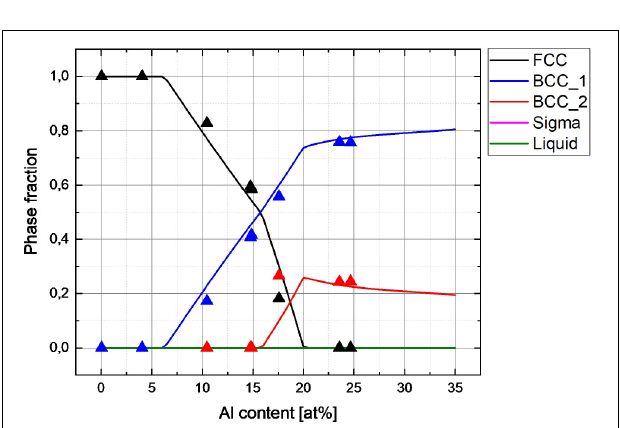
FIGURE 11 | Phase formation in the Al x CoCrFeNi alloy system homogenized at 1350 K in dependence on the Al content; lines: CALPHAD calculations, symbols: experimental data derived from structural